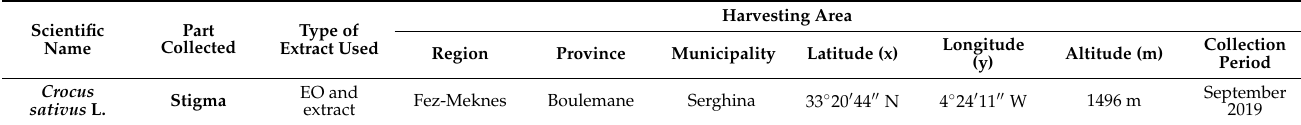
Table 7. Origin, part used, location, and harvesting period of Crocus sativus .